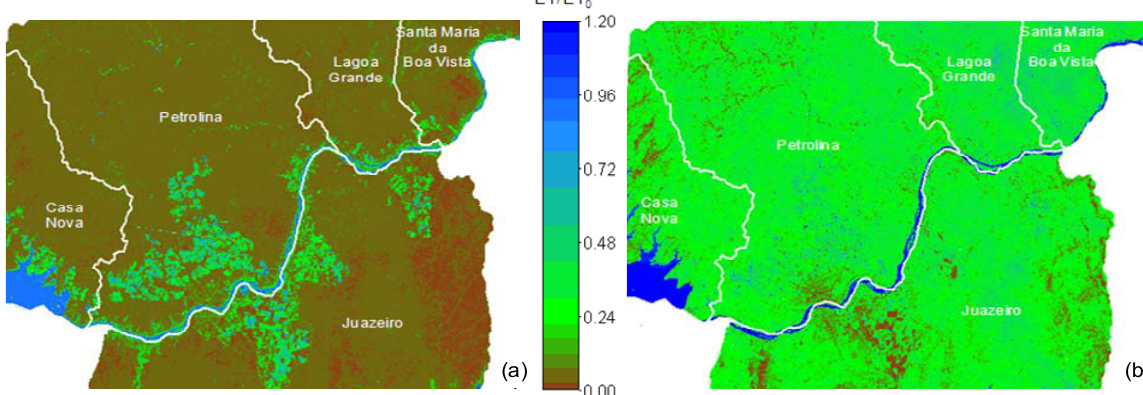
Figure 10. Images of the satellite overpass ET/ET agro-meteorological stations in the Low-Middle São Francisco river basin. ( a ) October 2005. ( b ) January